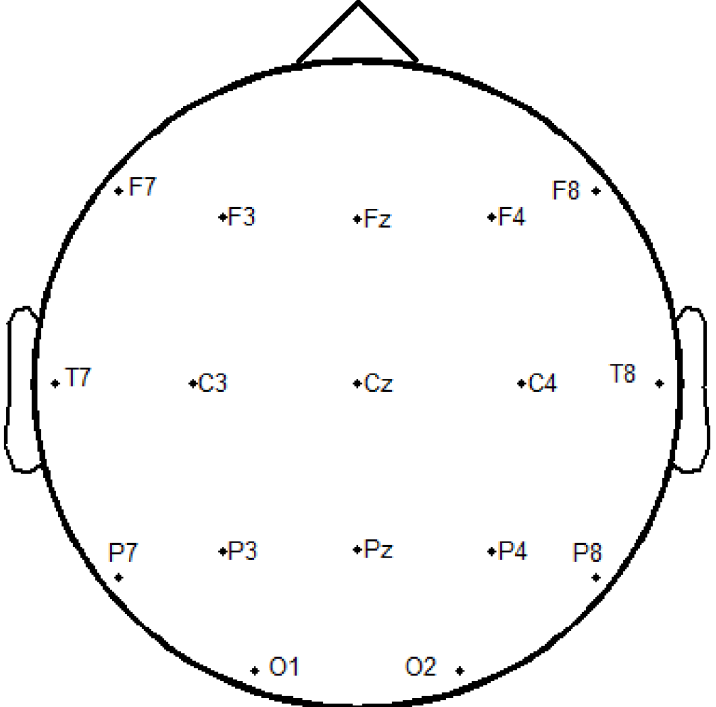
Fig 3. The topographic map of sixteen signal electrodes and the ground electrode (Fz). The seven electrodes over the occipital region (P7, P3, Pz, P4, P8, O1, O2) were selected for data recordings in the